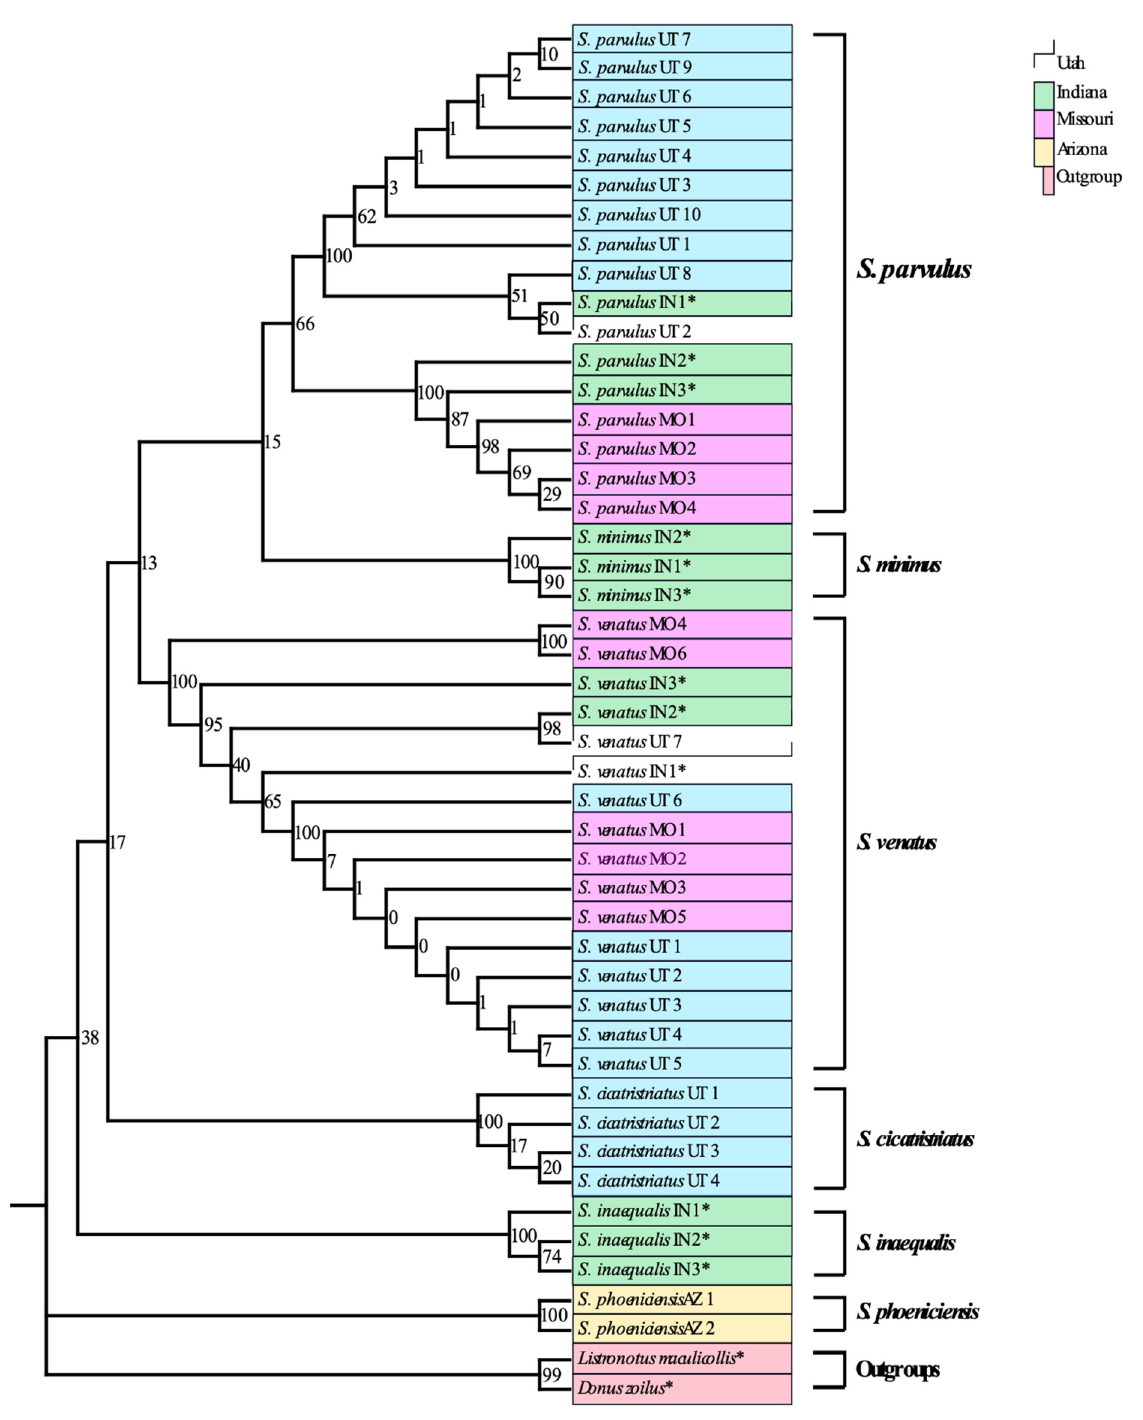
Figure 1. Maximum likelihood tree of COI sequences from Sphenophorus parvulus, S. venatus , S. minimus , S. inaequalis , S. cicatristriatus , and S. phoeniciencis adults. Collection location is represented by color blocks; Utah (blue), Indiana (green), Missouri (purple), Arizona (yellow), outgroups (red). Replicate numbers are indicated to the right of the scientific name and collection state (Utah = UT, Indiana = IN, Missouri = MO, Arizona-AZ). Numbers at nodes are bootstraps values (1000 bootstrap replicates as percentages). * indicates sequences obtained from [17].